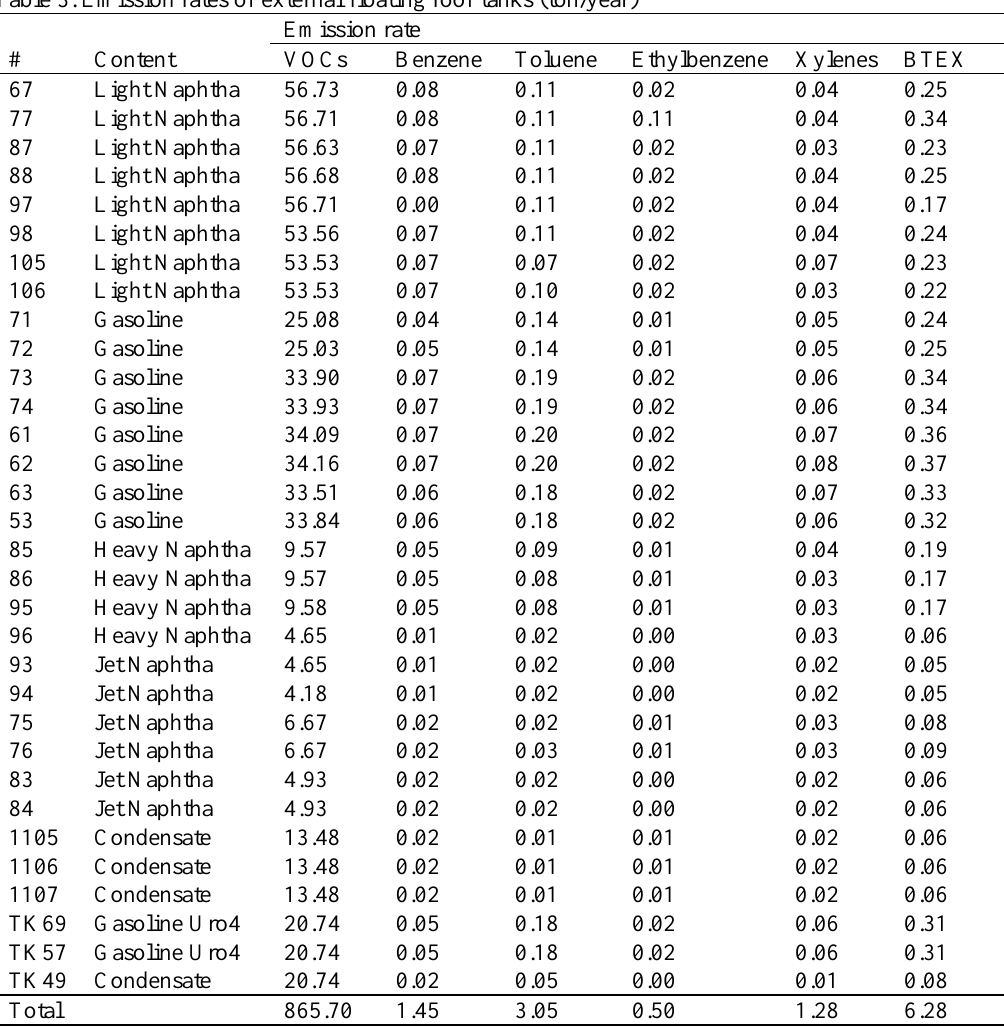
Table 3. Emission rates of external floating roof tanks